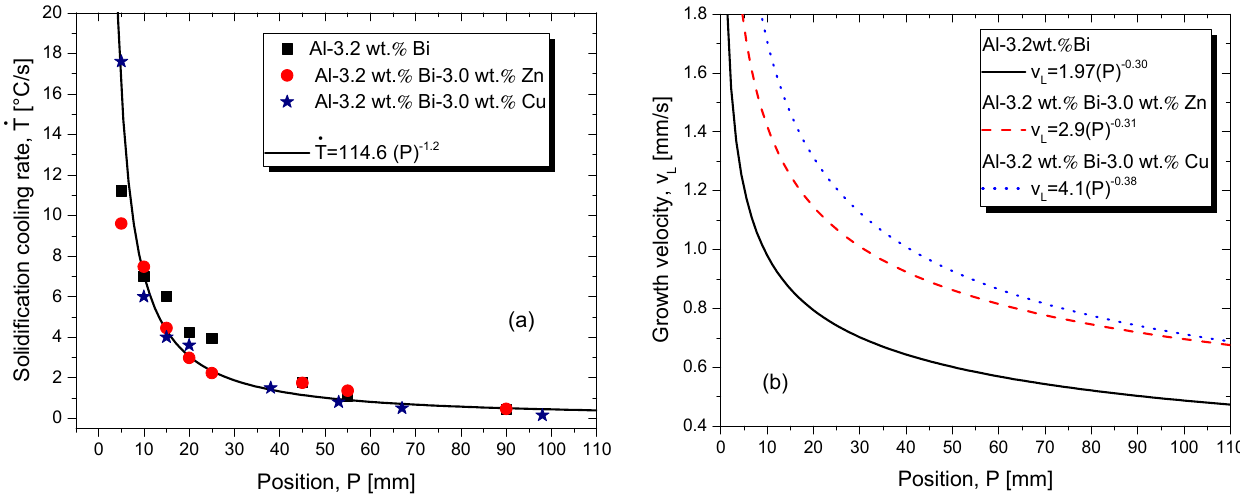
Figure 3. Experimental variations of ( a ) solidification cooling rates and ( b ) growth rates along the casting length of the evaluated Al-Bi(-Cu,-Zn) alloys.